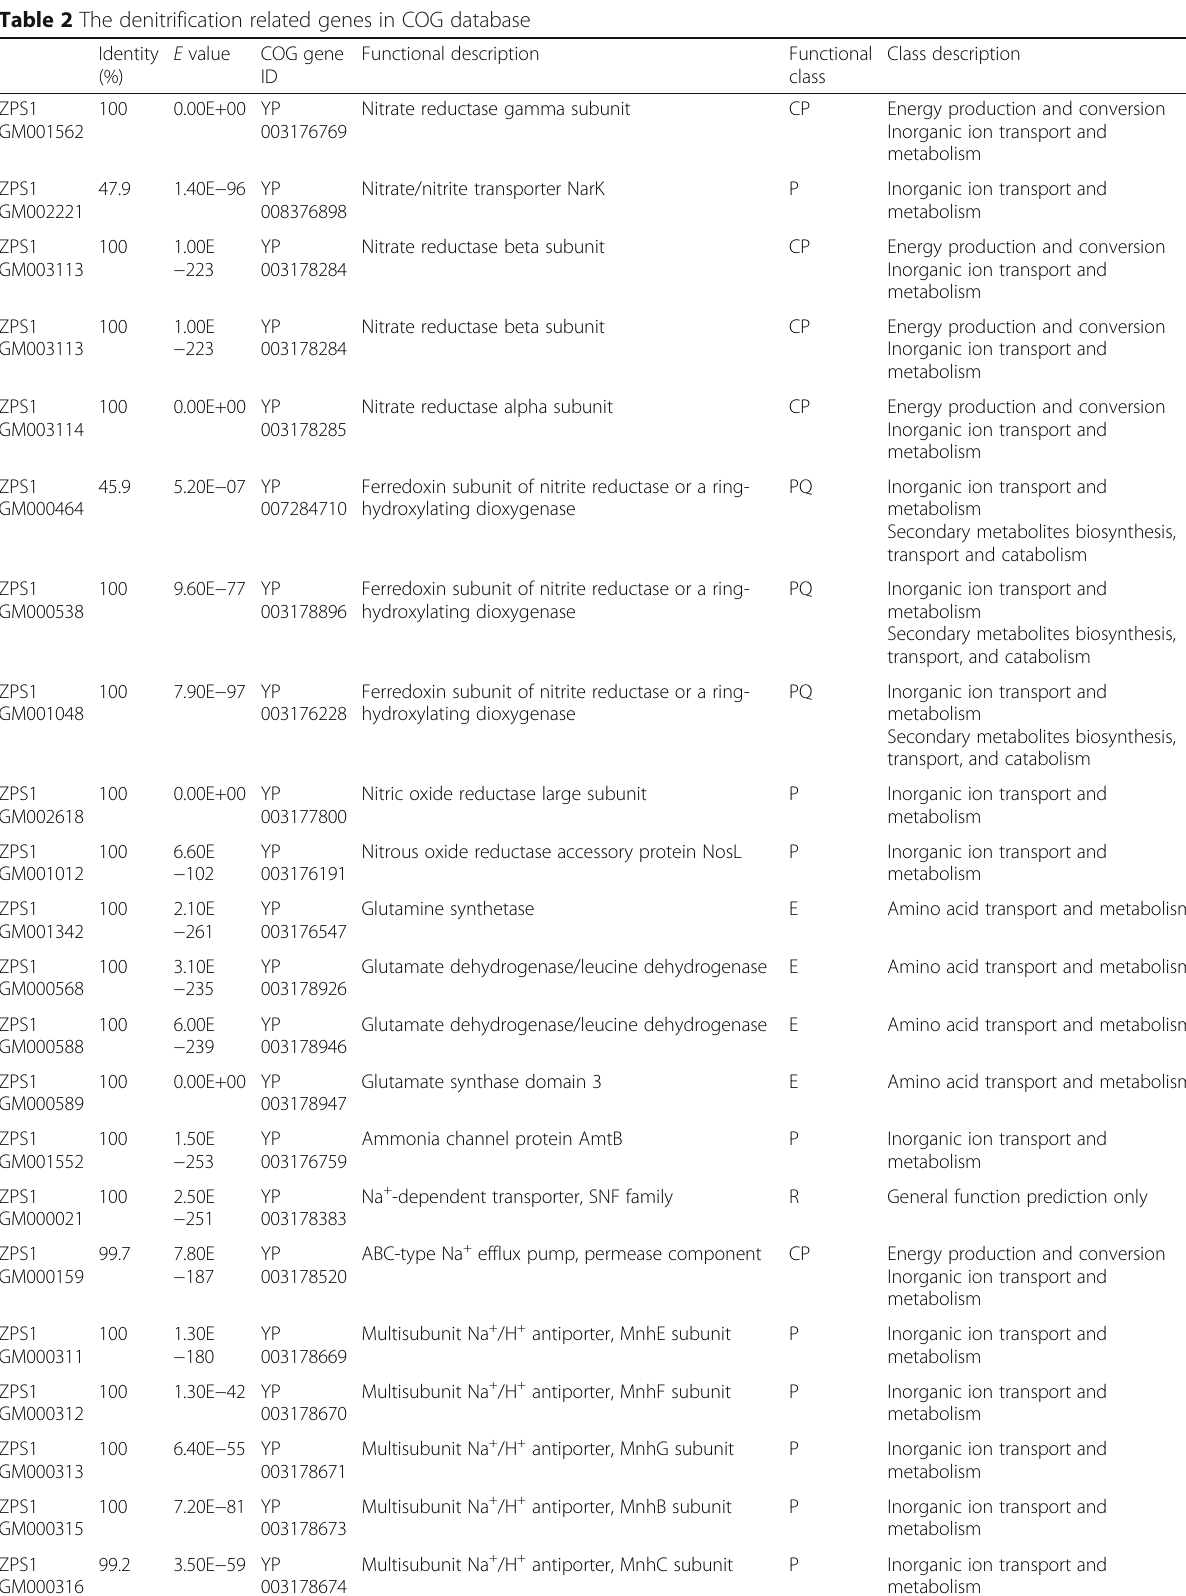
Table 2 The denitrification related genes in COG